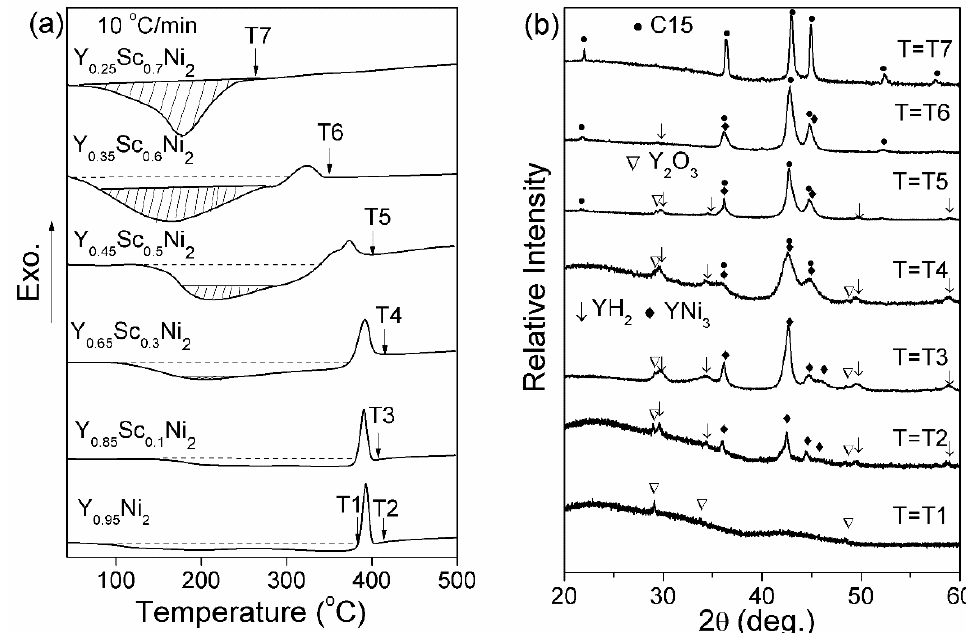
Figure 5. Differential scanning calorimetry (DSC) profiles of Y–Sc–Ni compounds after hydrogenation at 100 °C-5 MPa-24 h ( a ) and the corresponding XRD patterns ( b ).